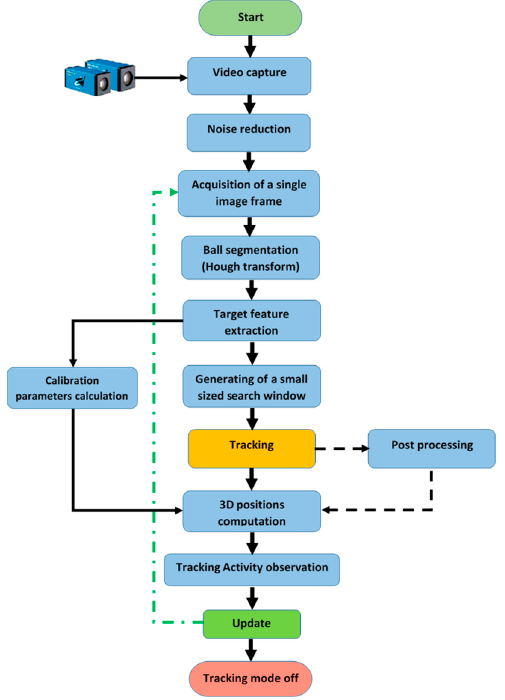
Figure 11. Detailed diagram of the visual tracking system.